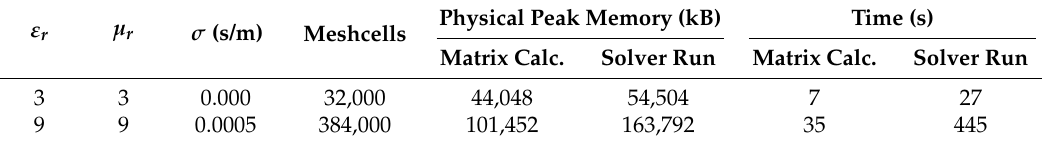
Table 3. Model B2 : Wire embedded in a fictitious dielectric and ferromagnetic coating. Computational